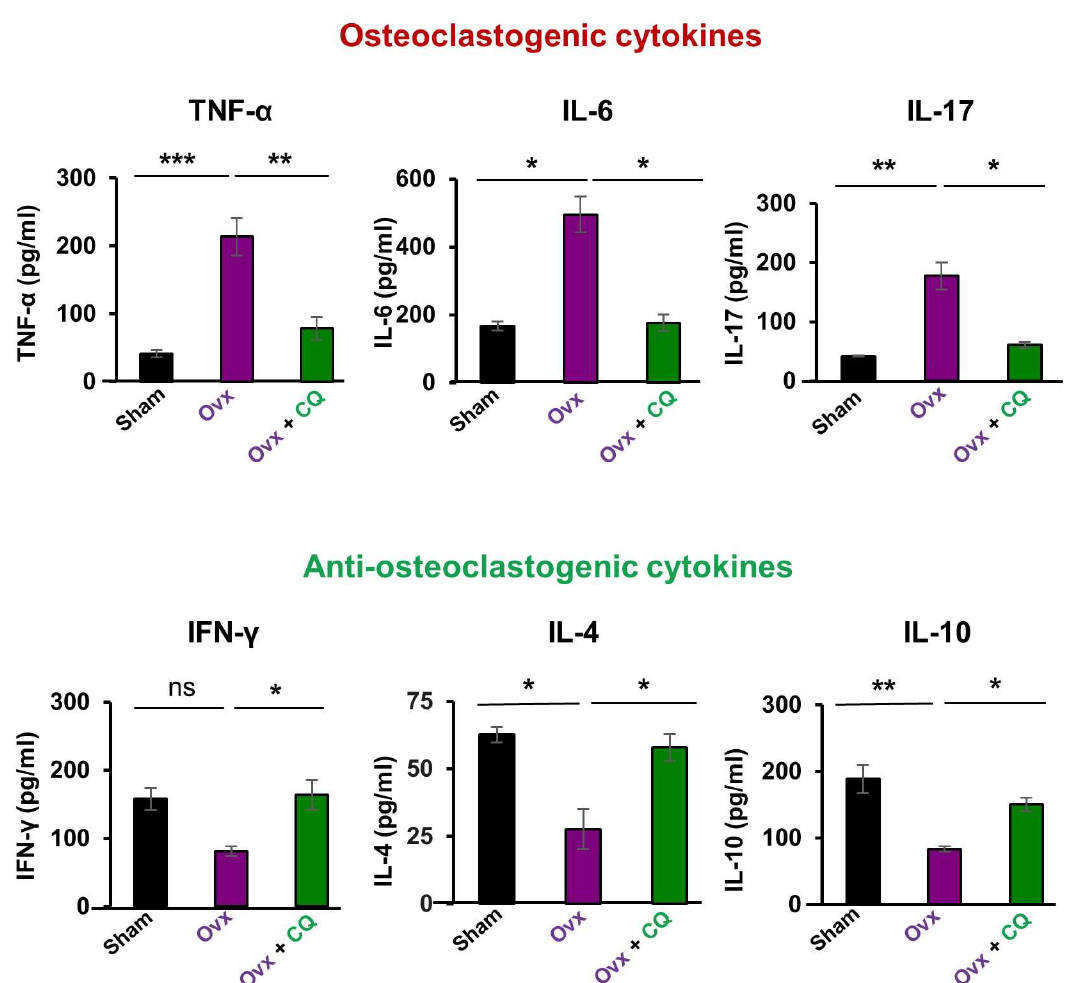
Figure 10. CQ skews cytokine balance in Ovx mice: Serum samples from all the three groups viz., Sham, Ovx, and Ovx + CQ were analyzed for levels of pro and anti-inflammatory cytokines by ELISA. ANOVA was used to analyse the results, and then unpaired Student t-tests were used to compare the indicated groups. Values are expressed as mean ± SEM, and equivalent outcomes were observed in two independent experiments. For the indicated groups, p 0.05 (* p ≤ 0.05, ** p ≤ 0.01, *** p ≤ 0.001) was used as the cutoff for statistical significance.